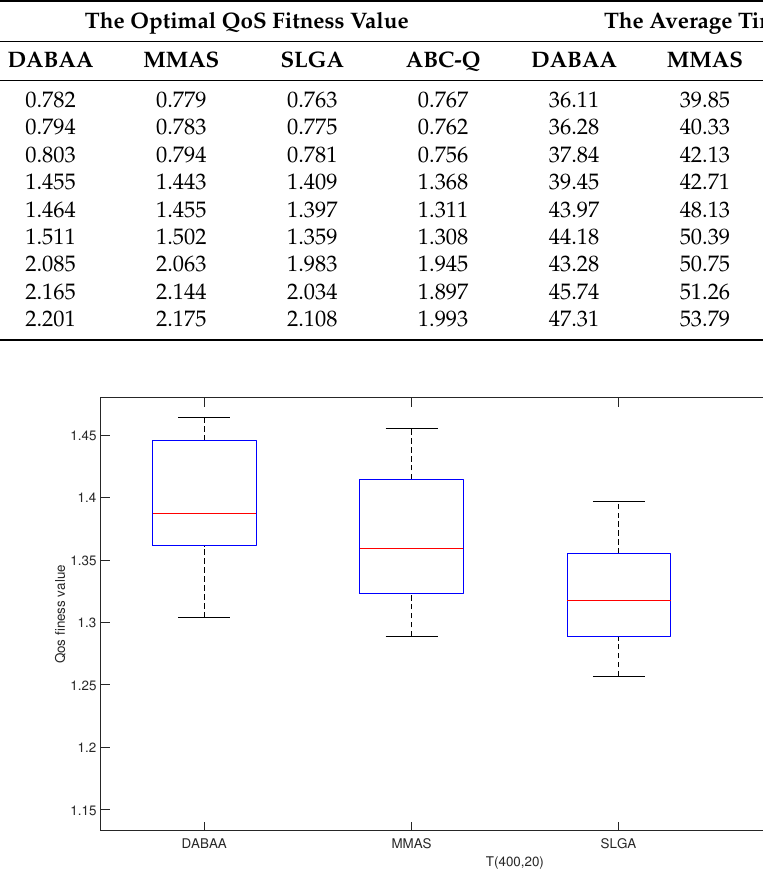
Figure 6. Boxplot of QoS fitness values.